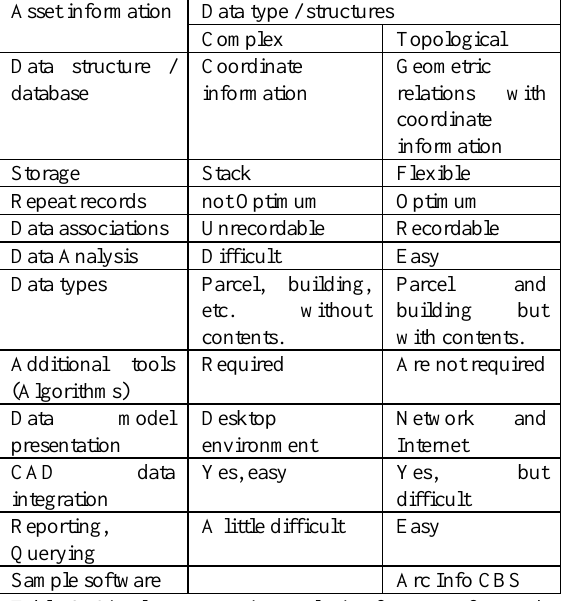
Table 8. Simple comparative analysis of systems for producing digital maps specific to cartography study area.